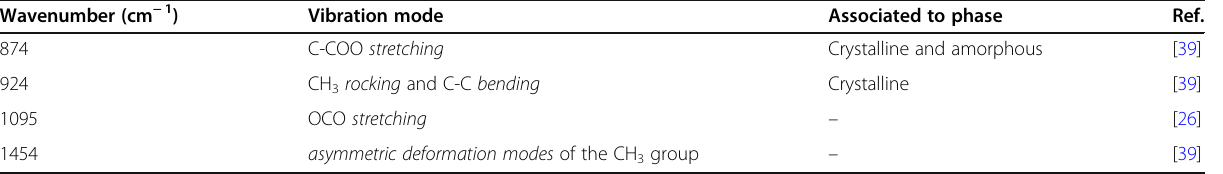
Table 1 Assignments of the analyzed bands (labelled in Fig. 6b) to specific vibrations of PLA chains Wavenumber (cm − 1 )